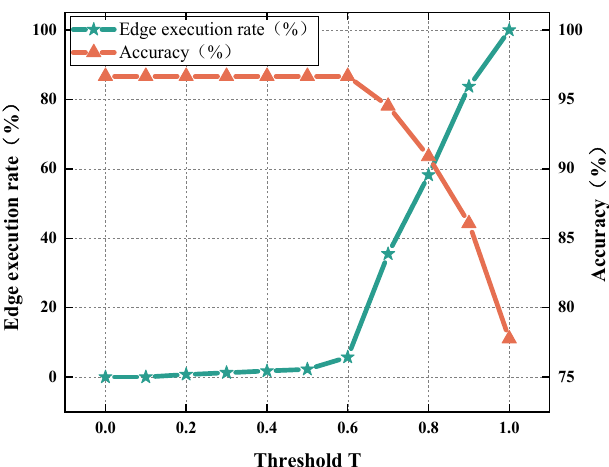
Figure 6. Relationship between threshold T and edge execution rate and accuracy.